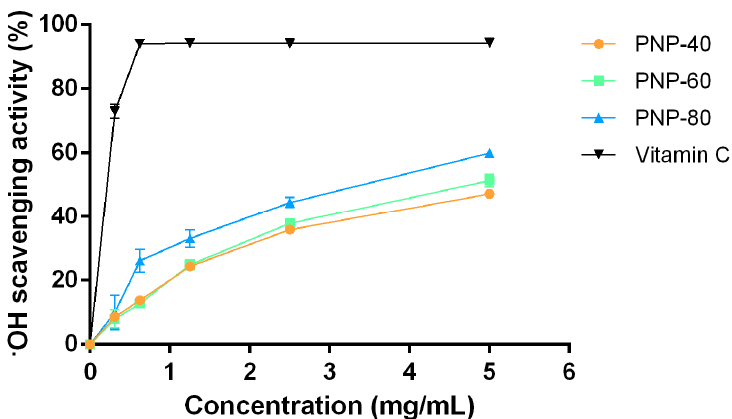
Figure 2. Hydroxyl radical scavenging activity of PNPs and vitamin C. The experiments were conducted in triplicate independently ( n = 3), and the data are expressed as the means ± standard error (SE). Low-molecular-weight polysaccharides have a less compact structure than